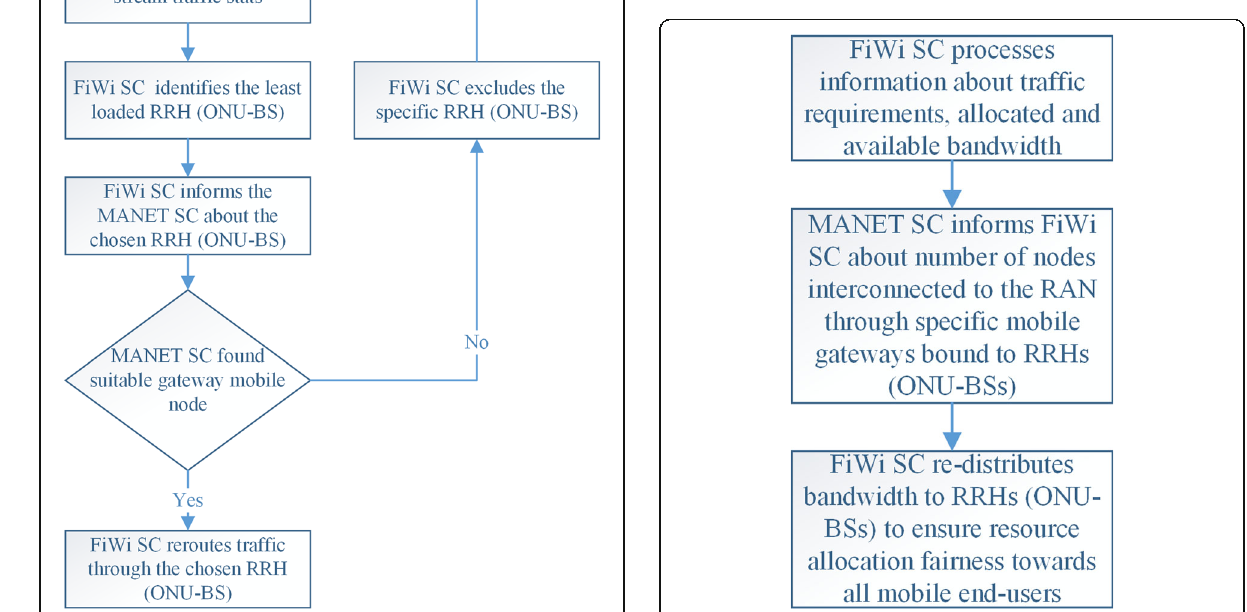
Fig. 9 Federated tasks performed by FiWi and MANET SDN controllers (SCs) to provide load balancing